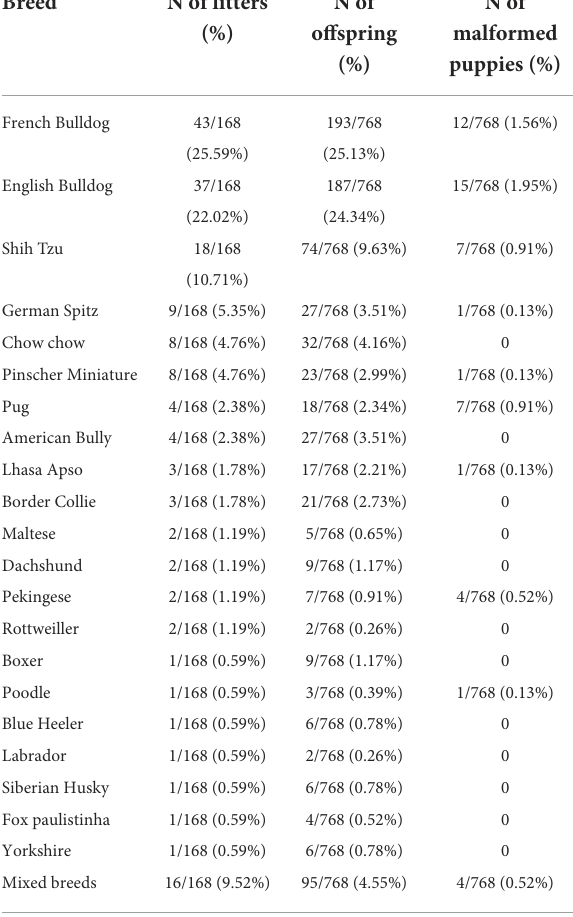
TABLE 3 Number and (%) of litters, offspring, and malformed puppies by breed, attended in SORA (Service of Obstetrics and Animal Reproduction) from January 2017 to December